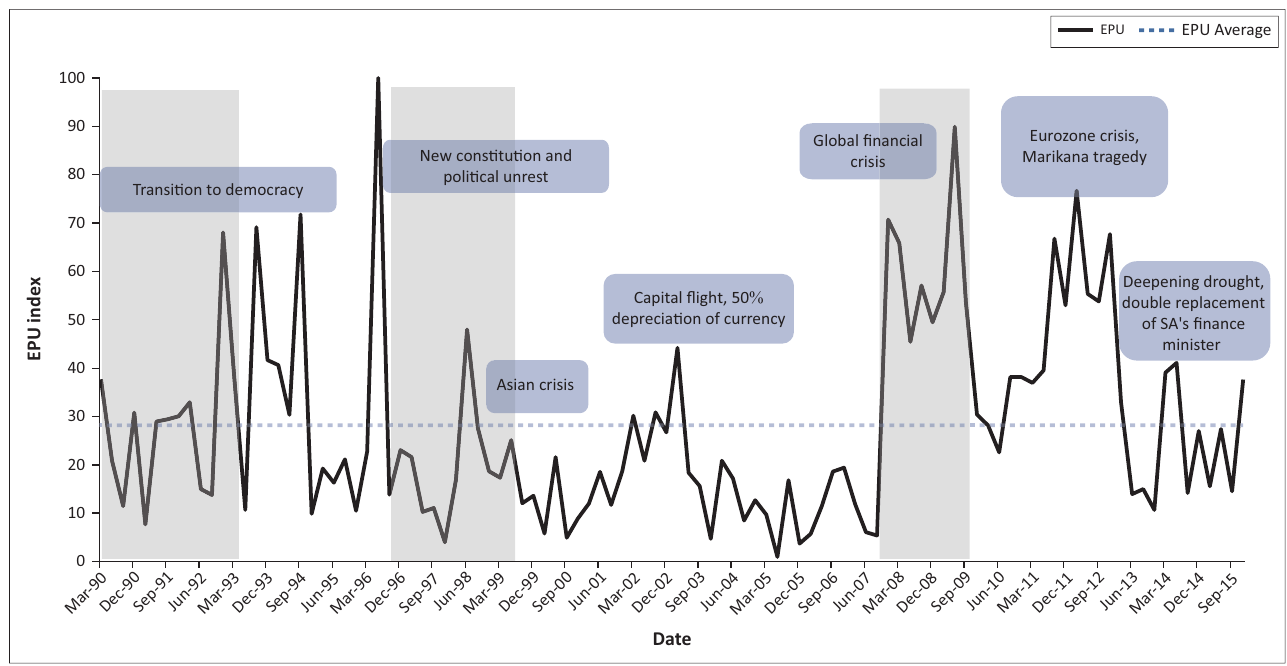
FIGURE 1: Economic policy uncertainty